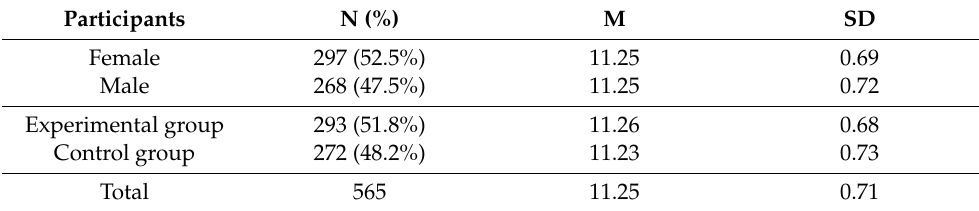
Table 1. Description of the study participants.